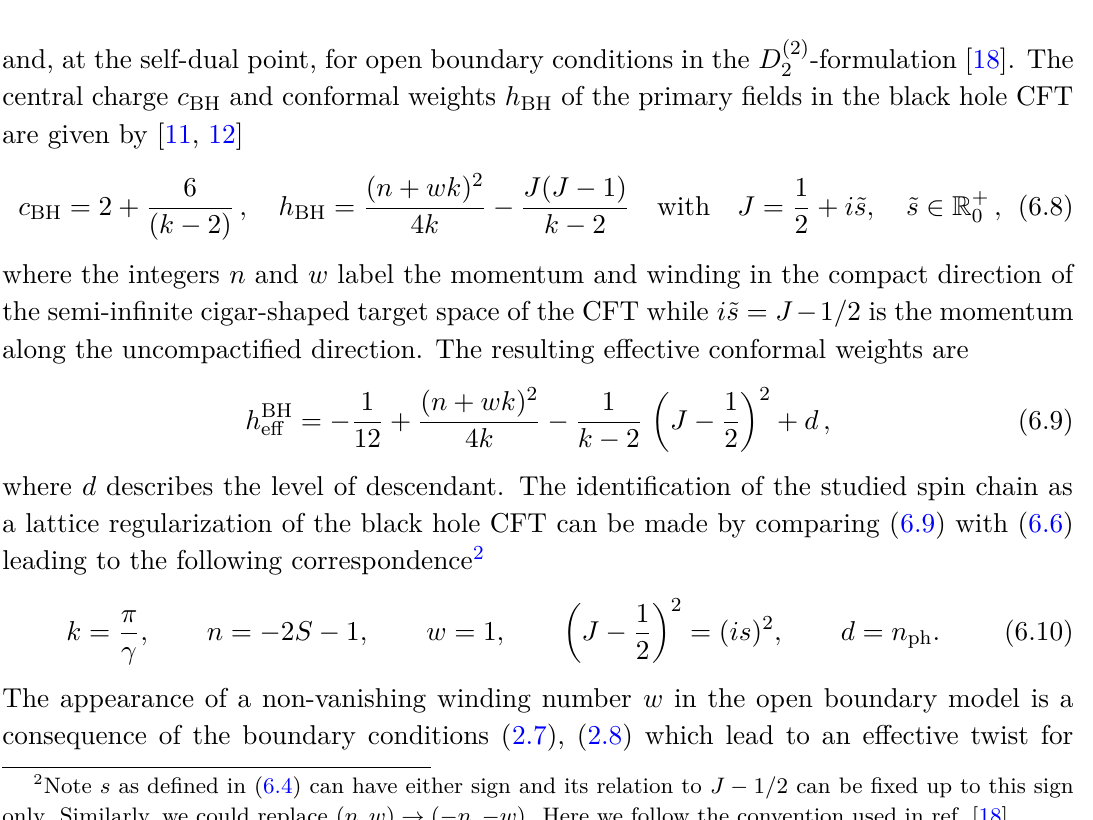
Figure 7 . The effective central charge (6.7) of the staggered spin chain as a function of the anisotropy is represented as the solid black line. Dashed colored lines are plots of (6.7) in sectors with given spin S , crosses represent the effective central charges c eff obtained from the Bethe ansatz solutions for large L . Vertical lines represent the ground state